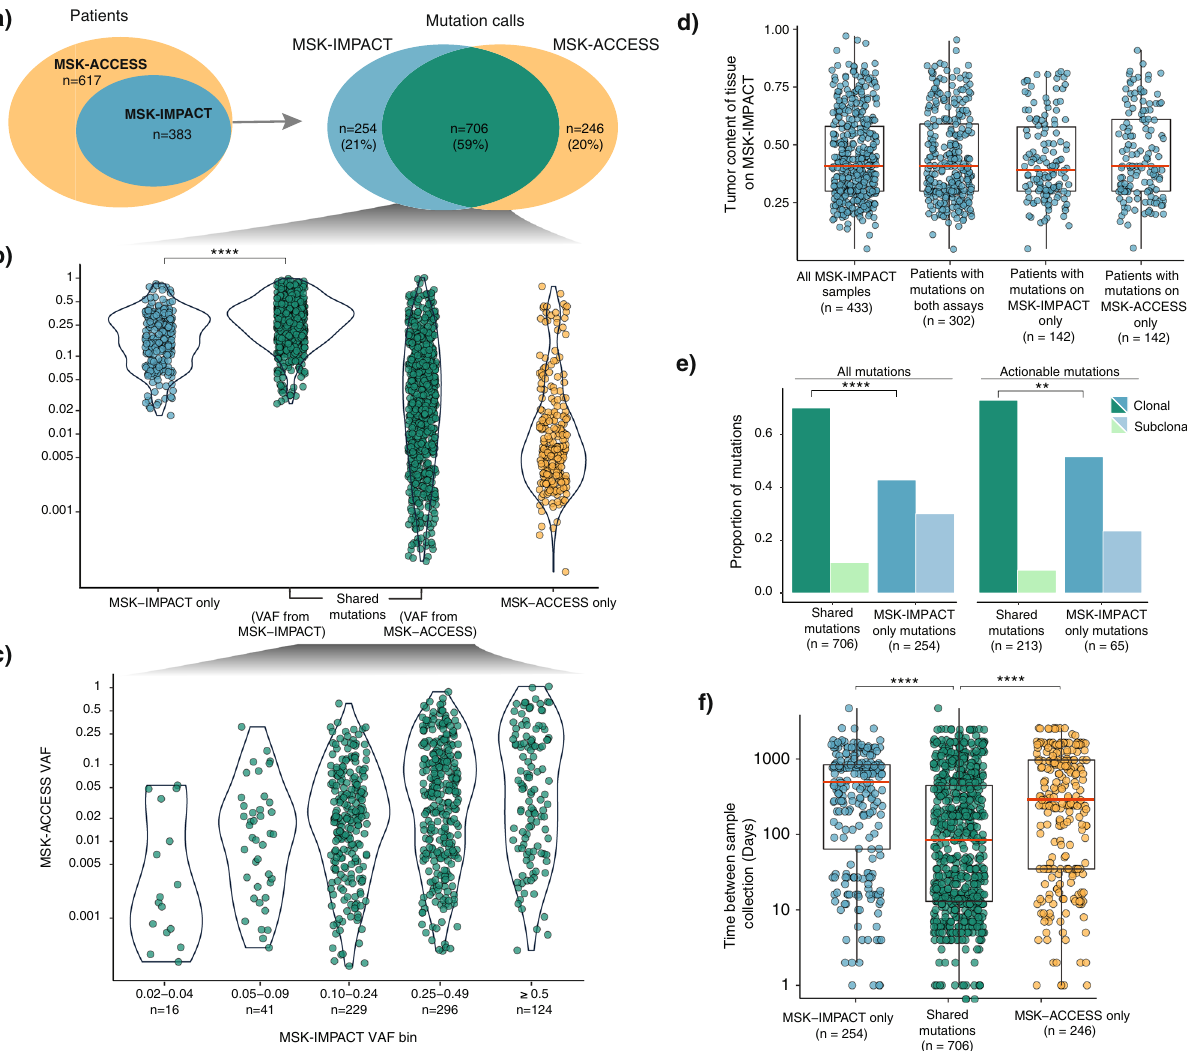
Fig. 3 Comparison of mutation calls between ctDNA and tissue. a Venn diagrams indicating the number of samples with concurrent cfDNA and tissue testing ( n = 383) and the number of mutation calls identi fi ed in each (total n = 1206). b VAF distribution of mutations identi fi ed by MSK-ACCESS-only, shared by both MSK-ACCESS and MSK-IMPACT, and by MSK-IMPACT only ( p = 2.06×10 − 18 ). The p value was obtained from pairwise comparisons using two-sided Mann – Whitney U -tests and adjusted for multiple testing using the Bonferroni method. c Comparison of VAF distributions of mutations identi fi ed in both the ctDNA and tissue from both MSK-ACCESS and MSK-IMPACT. d Tumor purity distribution of MSK- IMPACT tissue samples of (i) all patients in the concordance analysis, (ii) samples belonging to patients presenting actionable mutations on both assays, (iii) samples belonging to patients with actionable mutations detected in MSK-IMPACT only, and (iv) samples belonging to patients with actionable mutations detected in MSK-ACCESS only. e Clonality of all and actionable mutations detected in MSK-IMPACT only and in both assays (all mutations: p = 8.10×10 − 13 , actionable mutations: p = 6.06×10 − 3 ). The p values were obtained from two-by-two Fisher ’ s exact tests and adjusted for multiple testing using the Bonferroni method. f Absolute time difference ( Δ DOP) between MSK-IMPACT tissue sample and MSK-ACCESS blood sample collection for patients with actionable mutations in MSK-IMPACT only ( p = 3.63×10 − 14 ), in both assays, and in MSK-ACCESS only ( p = 1.33×10 − 9 ). The p values were obtained from pairwise comparisons using two-sided Mann – Whitney U -tests and adjusted for multiple testing using the Bonferroni method. All boxplots show the median (center line) and 25th and 75th percentiles (bounding box) along with the 1.5 interquartile range